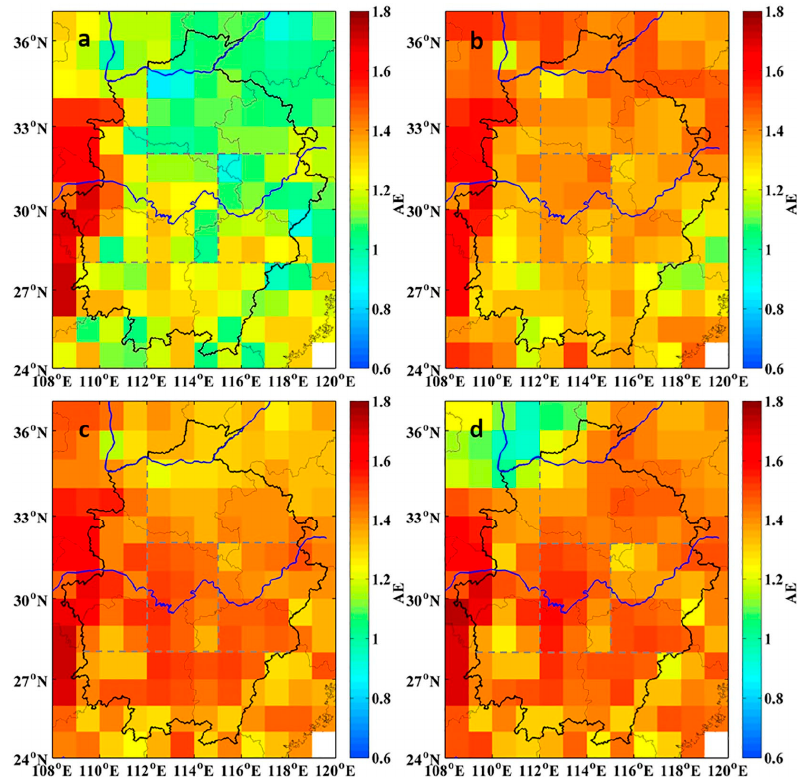
Figure 4. Seasonal mean AE from 2001 to 2015 over central China: ( a ) spring, ( b ) summer, ( c ) autumn, and ( d ) winter.